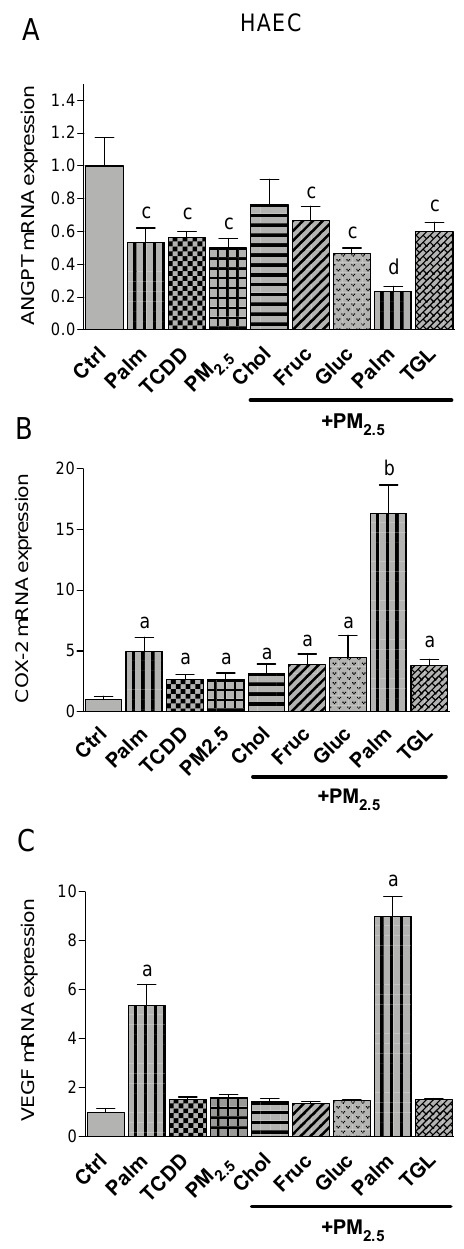
Figure 5. E ff ect of nutritional compounds on PM 2.5 -induced expression of atherogenic markers in HAEC; Cells were treated with 1 nM TCDD and 10 µ g / mL PM 2.5 for 24 h. The e ff ect of nutritional factors cholesterol (Chol, 10 µ g / mL), fructose (Fruc, 25 mM), glucose (Gluc, 25 mM), palmitic acid (Palm, 5 µ M), and triglyceride (TGL, 10 µ g / mL) was tested in presence of PM 2.5 after 24 h treatment. Control cells were treated with the corresponding vehicle. The mRNA expression of ( A ) Angiopoetin (ANGPT), ( B ) COX-2, and ( C ) VEGF was analyzed by qPCR. The expression was corrected against the housekeeping gene ß-actin. a significantly higher than Ctrl; b significantly higher than cells treated with PM 2.5 or Palm only; c significantly lower than Ctrl; d significantly lower than cells treated with Palm or PM 2.5 only p < 0.05.